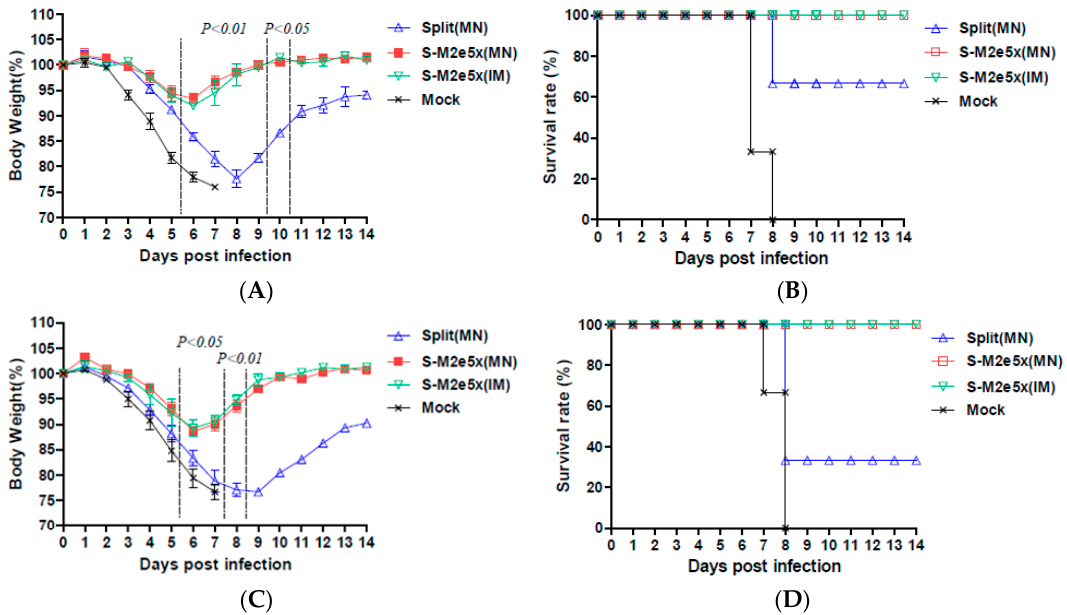
Figure 8. Immune sera from mice with split and M2e5x VLP vaccines together confer improved cross protection. Naïve mice ( N = 3) were intranasally infected with 3 × LD 50 of influenza virus mixed with immune sera. ( A ) Body weight changes and ( B ) survival rates in naïve mice after infection with a mixture of A/PR8 (heterologous H1N1) virus and immune or mock sera. ( C ) Body weight changes and ( D ) survival rates in naïve mice after infection with a mixture of A/Mandarin duck (rgH5N1) virus and immune or mock sera. For statistical analysis, one-way ANOVA and Tukey’s post-multiple comparison test were performed. P values indicate significant differences between the immune sera of split MN or S-M2e5x MN as marked in the graph. Data represent mean ± SEM. Split MN; immune sera of split MN mice, S-M2e5x MN; co-immune sera of S-M2e5x MN mice, S-M2e5x IM; immune sera of S-M2e5x IM mice.